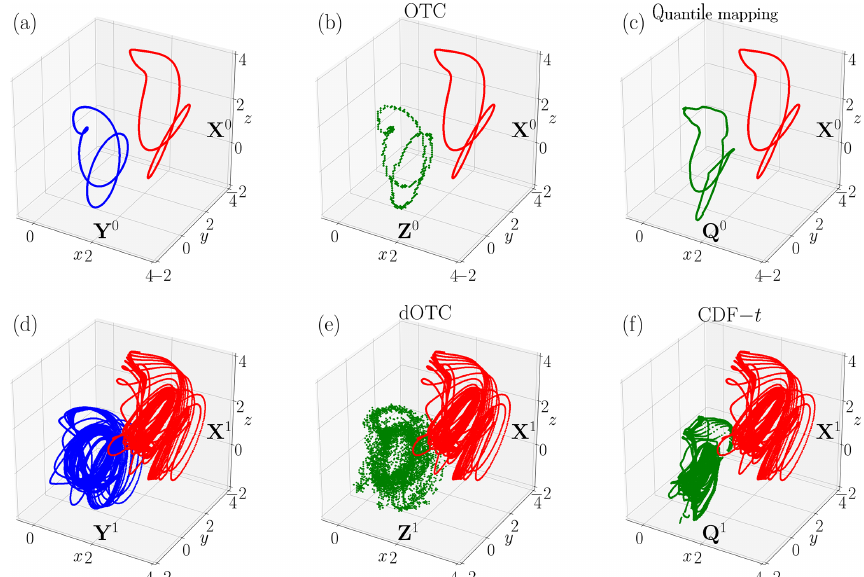
Figure 3. Bivariate histogram with bin size equal to 0 . 1. In each panel we have a Gaussian law centered on ( 0 , 0 ) with covariance 4 Id 2 ( ˆ P a Gaussian law centered on ( 10 , 0 ) with covariance 1 / 4 Id 2 ( ˆ P X 1 ) and a Gaussian law centered on ( 0 , 10 ) with covariance 1 / 4 Id 2 ( ˆ P X 1 ). The red arrow is the local evolution between ˆ P X 0 and ˆ P X 1 . (a) The probability distribution ˆ P Y 1 is the correction with OTC- t and D = Id 2 . The grey arrow is the estimation of the evolution of ˆ P Y 0 . (b) The probability distribution ˆ P Y 1 is the correction with dOTC and D given by Eq. (6). The grey arrow is the estimation of the evolution of ˆ P Y 0 .